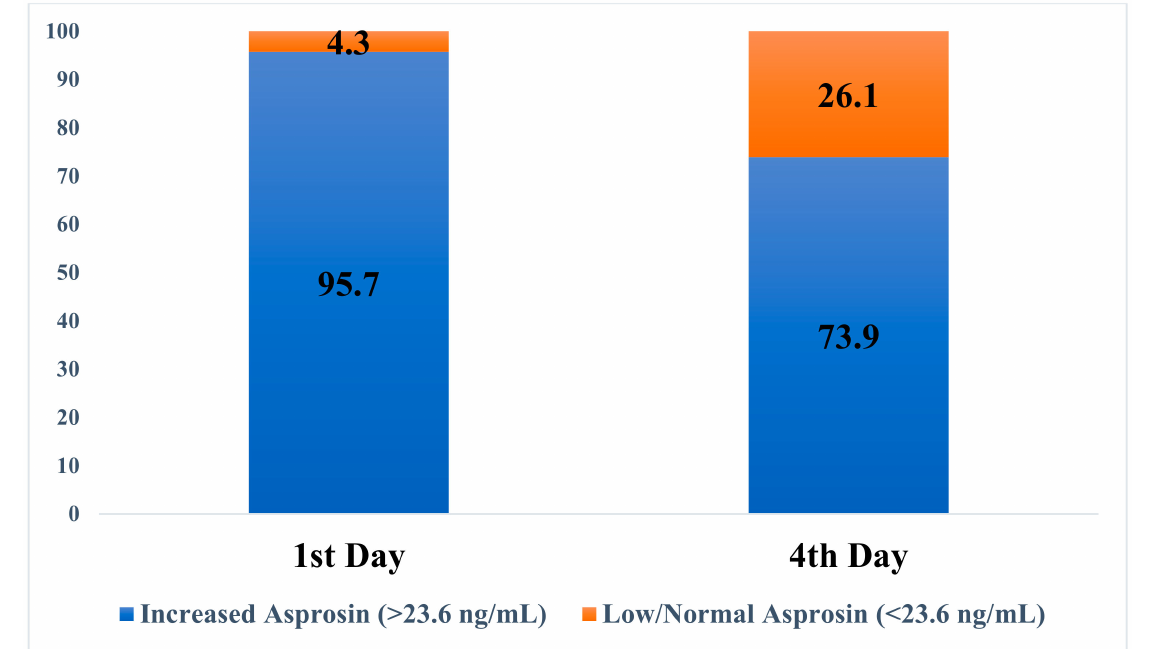
Figure 2. The distribution of patients with high/low–normal asprosin levels on the first and fourth days after EN